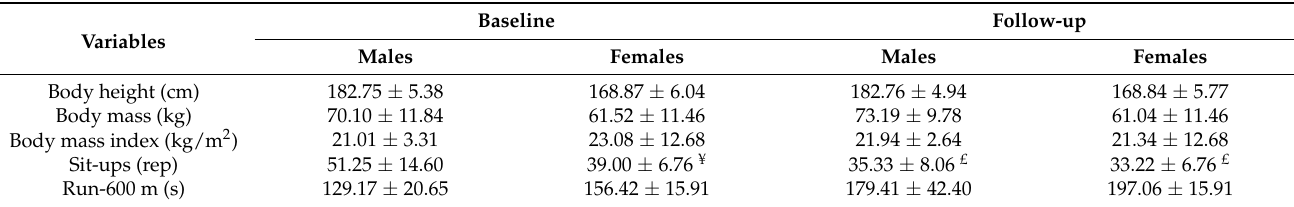
Table 4. Descriptive statistics (presented as means ± std. dev.) and post-hoc differences for study variables for the lockdown generation. Variables Body height (cm) Sit-ups